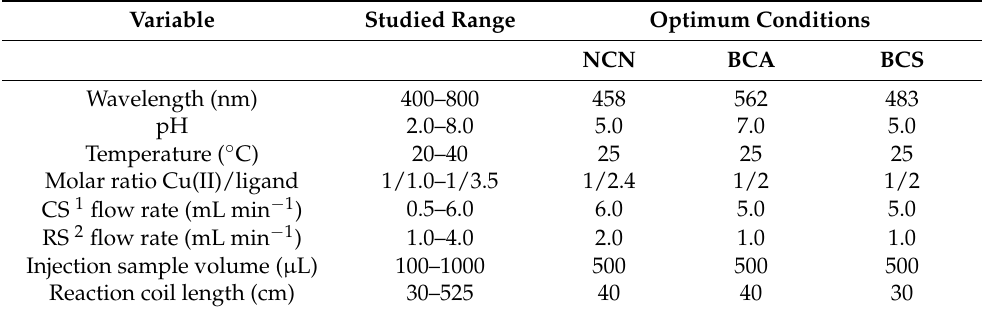
Table 1. Optimization of chemical parameters and manifold conditions for the proposed FIA method.